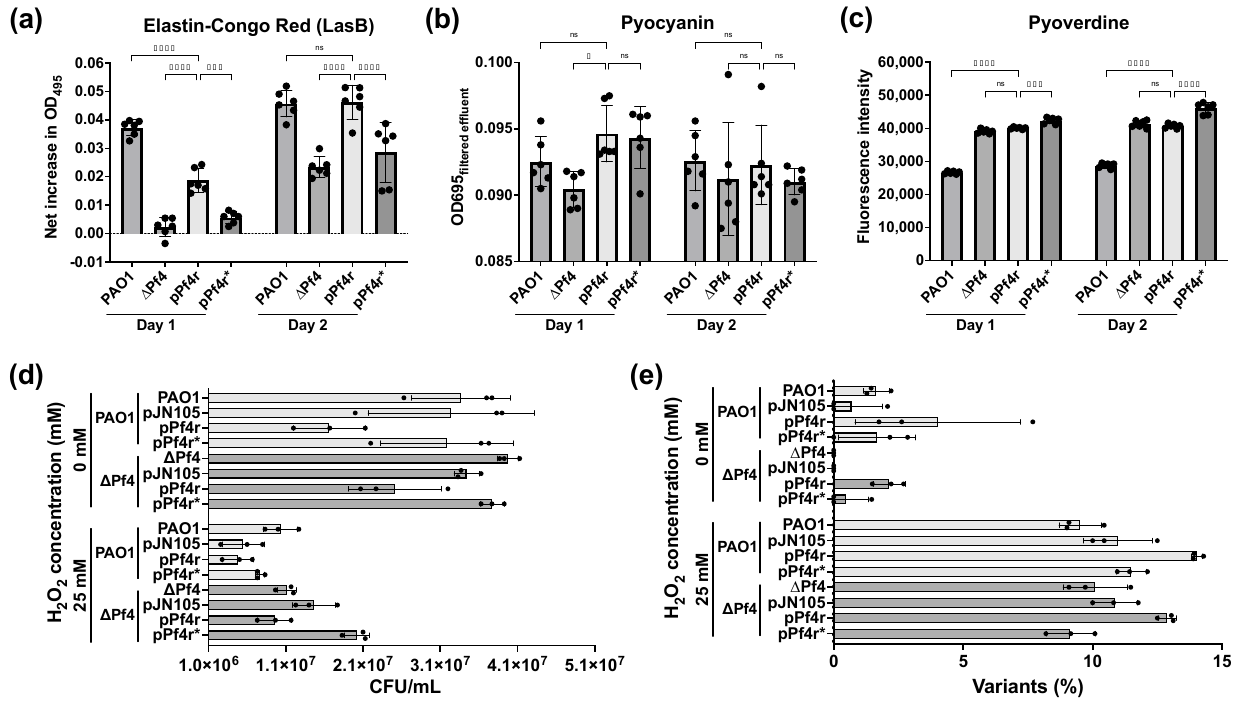
Figure 6. Pf4r restores LasB activity and slightly increases mutant frequencies. ( a , b ) Pyoverdine and pyocyanin production were semi-quantified by measuring emission fluorescence at 460 nm and by absorbance at OD 695 , respectively. ( c ) Extracellular protease activity in cell-free supernatant was measured using elastin-congo red for LasB (increase in absorbance at OD 495 ). Significant difference was determined using Dunnett’s multiple comparisons test. ( d ) The number of viable cells after 25 mM H 2 O 2 treatment for 30 min and ( e ) percentage of the mutant frequencies of Δ Pf4 and PAO1 after treatment with H 2 O 2 . For all assays, N = 3.